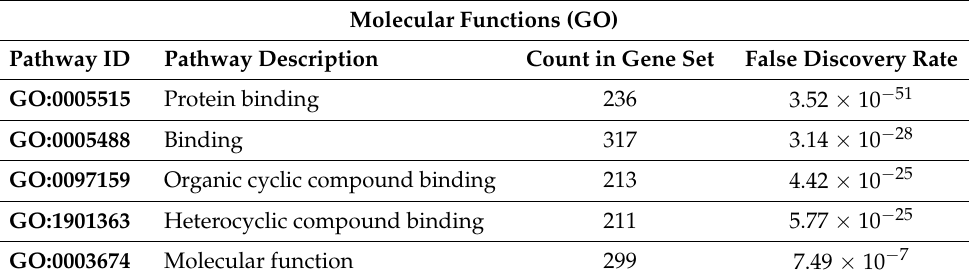
Table 2. Gene Ontology (GO) analysis of molecular functions.